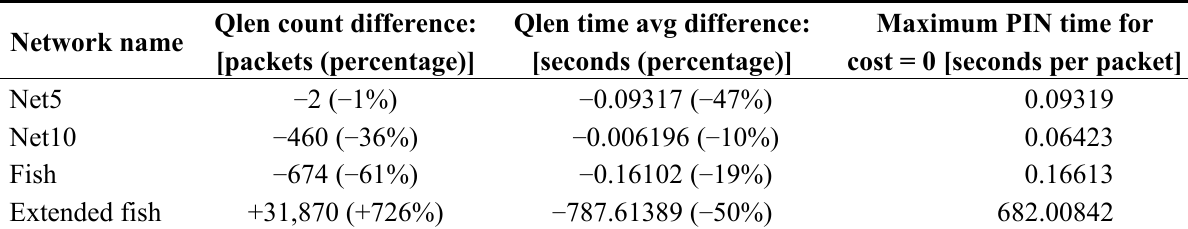
Table 3. PIN benefits and